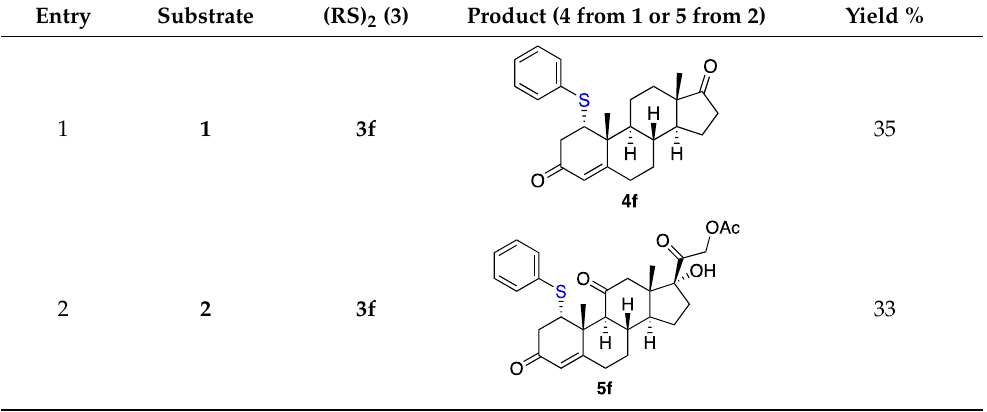
Table 3. Thio-Michael reactions.